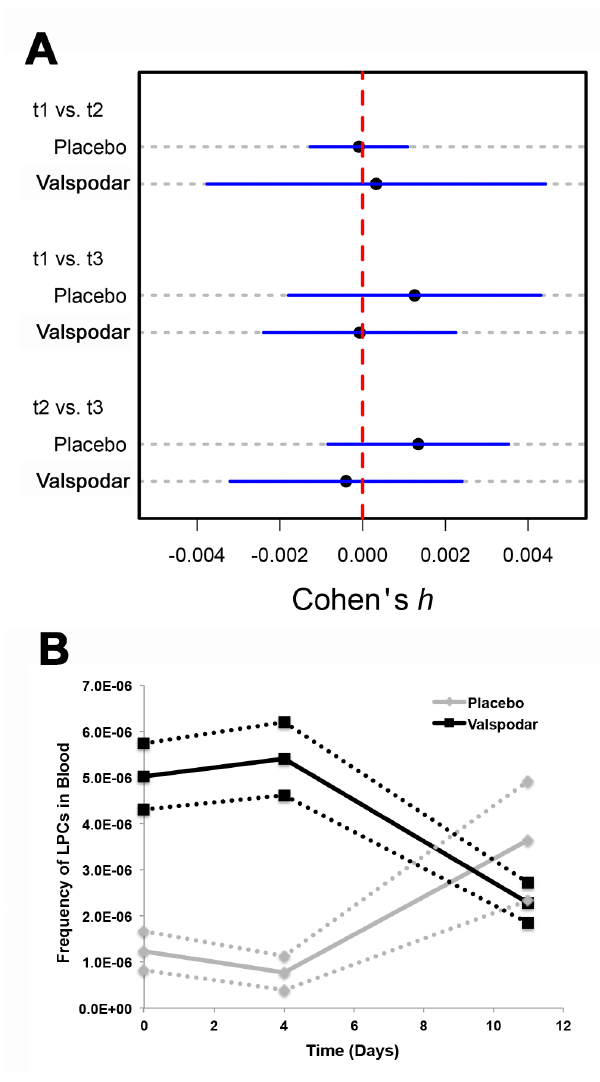
Figure 4. Effect of valspodar treatment on depletion of peripheral blood LPCs in dogs with diffuse large B-cell lymphoma. ( A ) Plots of effect sizes (Cohen’s h ), with corresponding 95% confidence intervals, associated with valspodar treatment on LPC frequency in peripheral blood. Effect sizes of valspodar treatment on changes in LPC frequency between all sampling time points are depicted. All calculated effect sizes were small, suggesting no effect of therapy on changes in peripheral blood LPC proportion between time points. However, the 95% confidence intervals are wide due to high variability in sample quality. t1=Day 0; t2=Day 4; t3=Day 11. ( B ) Mean frequency of blood LPCs from Day 0 to Day 11 in dogs receiving placebo (red lines, squares) and in dogs receiving valspodar (green lines, triangles). Dotted lines denote the 95% lower and upper boundaries of LPC frequencies for each